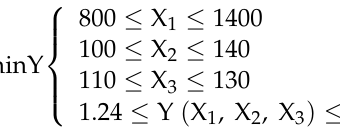
Figure 13. Comparison of power consumption in field trials and simulation trials.